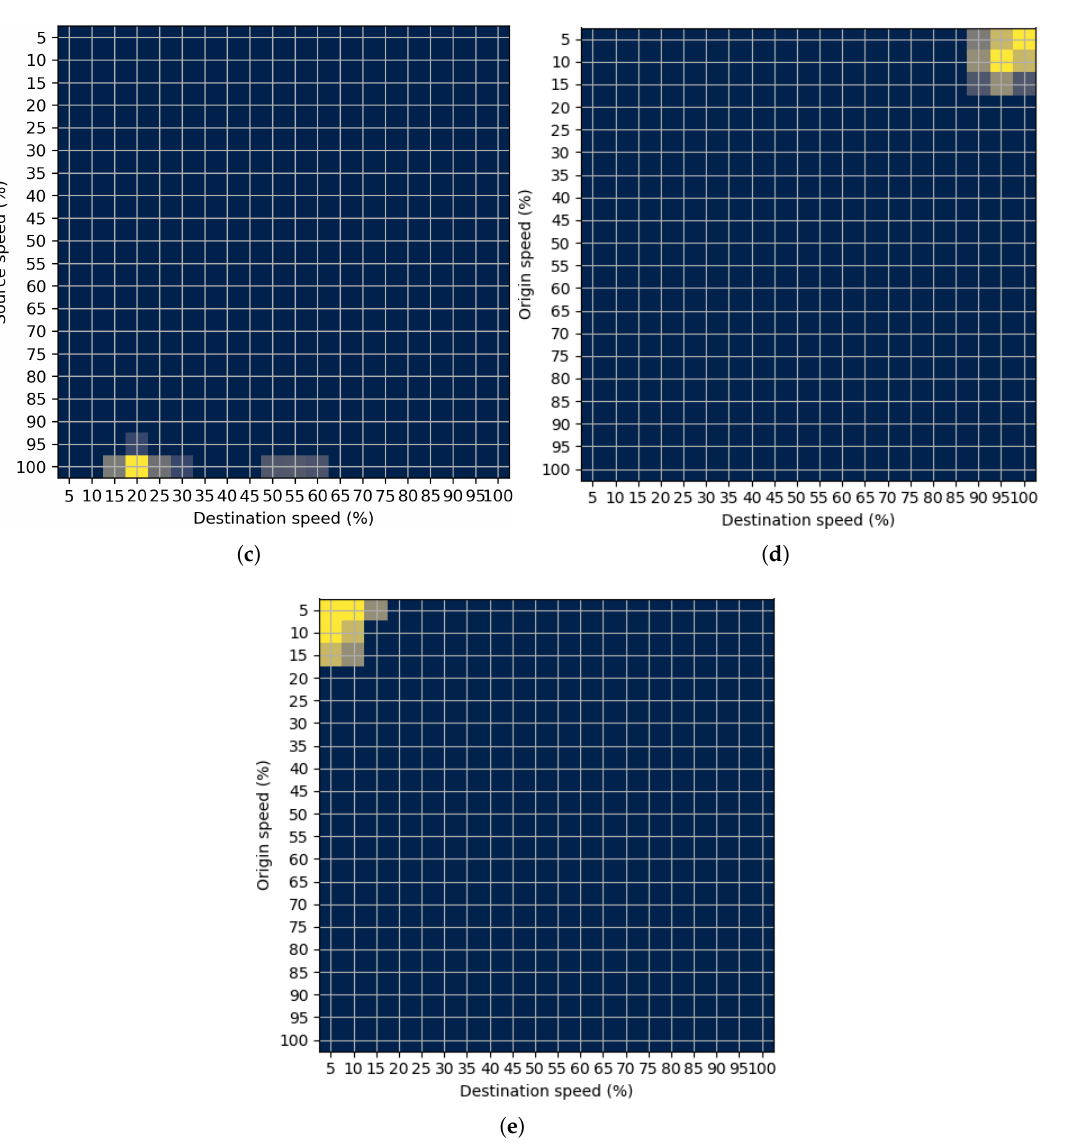
Figure 1. Examples of the characteristic STMs. ( a ) Free flow; ( b ) Unstable flow; ( c ) Bottleneck start; ( d ) Bottleneck end; ( e ) Heavy